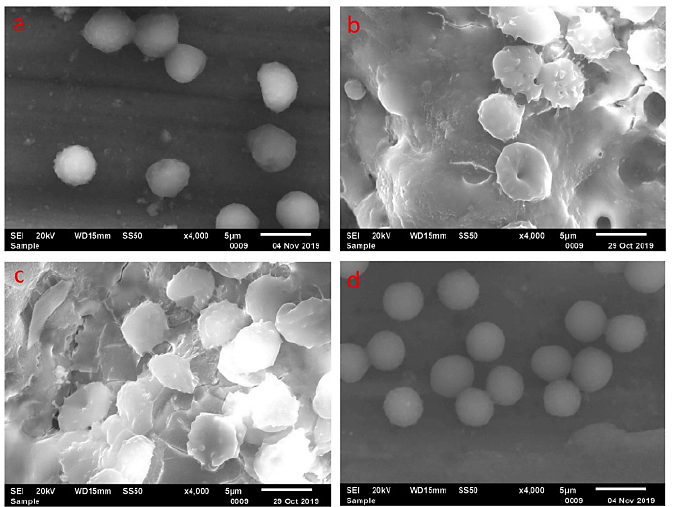
Figure 7. SEM images of platelets adhering to samples: ( a ) Mg alloy sample, ( b ) AO-coated sample, ( c ) AO–SA-coated sample, ( d ) AO–SA–CS-coated sample. Reprinted with permission from [76]; Copyright 2021 Elsevier.